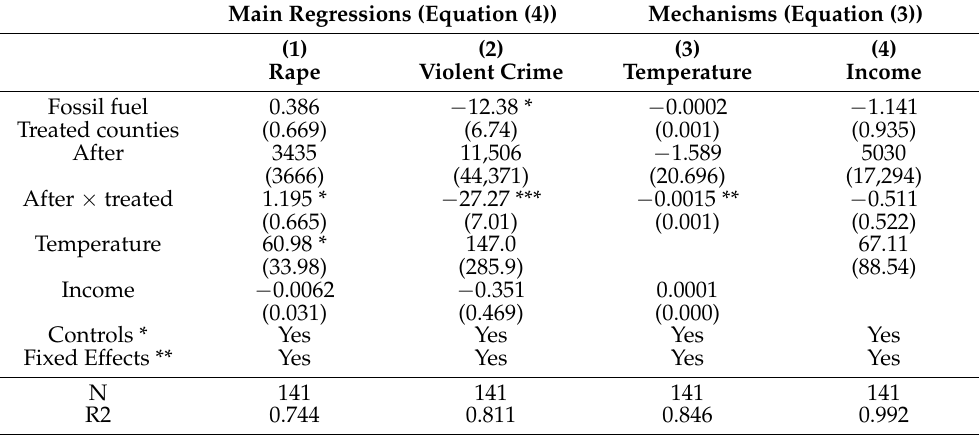
Table 6. Using the integrated mechanism approach based on DiD method (Equations (3) and (4)), when temperature and income level are the mechanism and fossil fuel consumption is the independent variable: